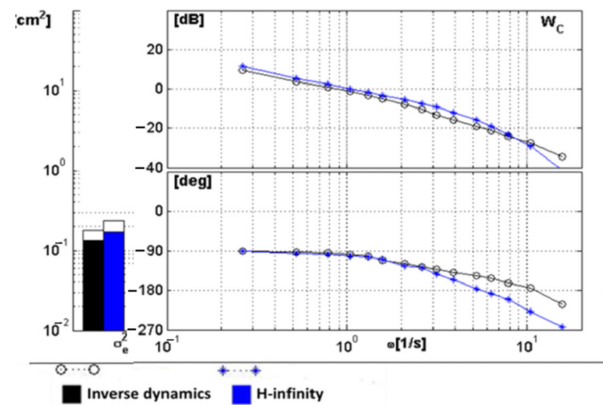
Figure 13. Results of experiments with